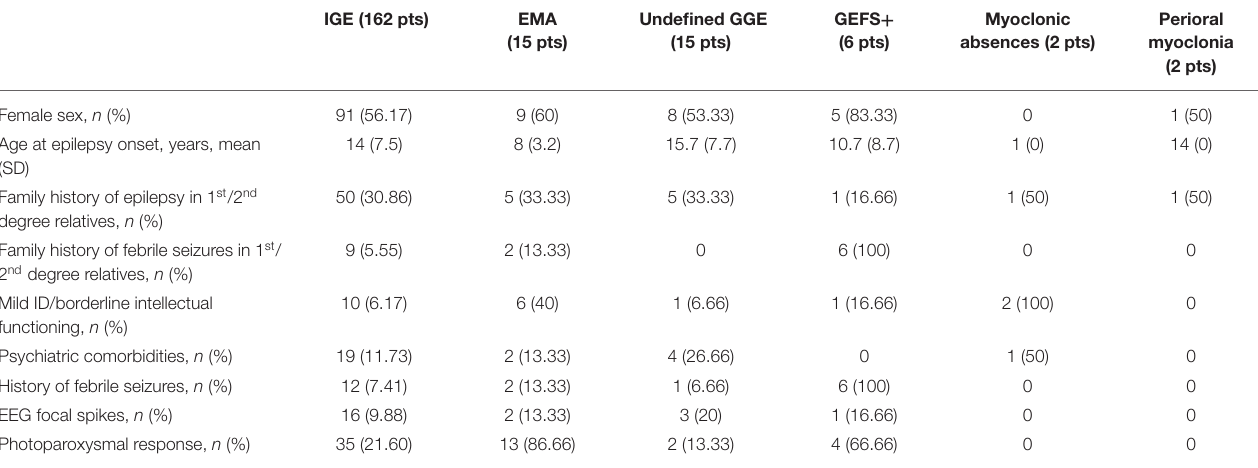
TABLE 1 | Main electroclinical characteristics stratified by epilepsy syndrome.